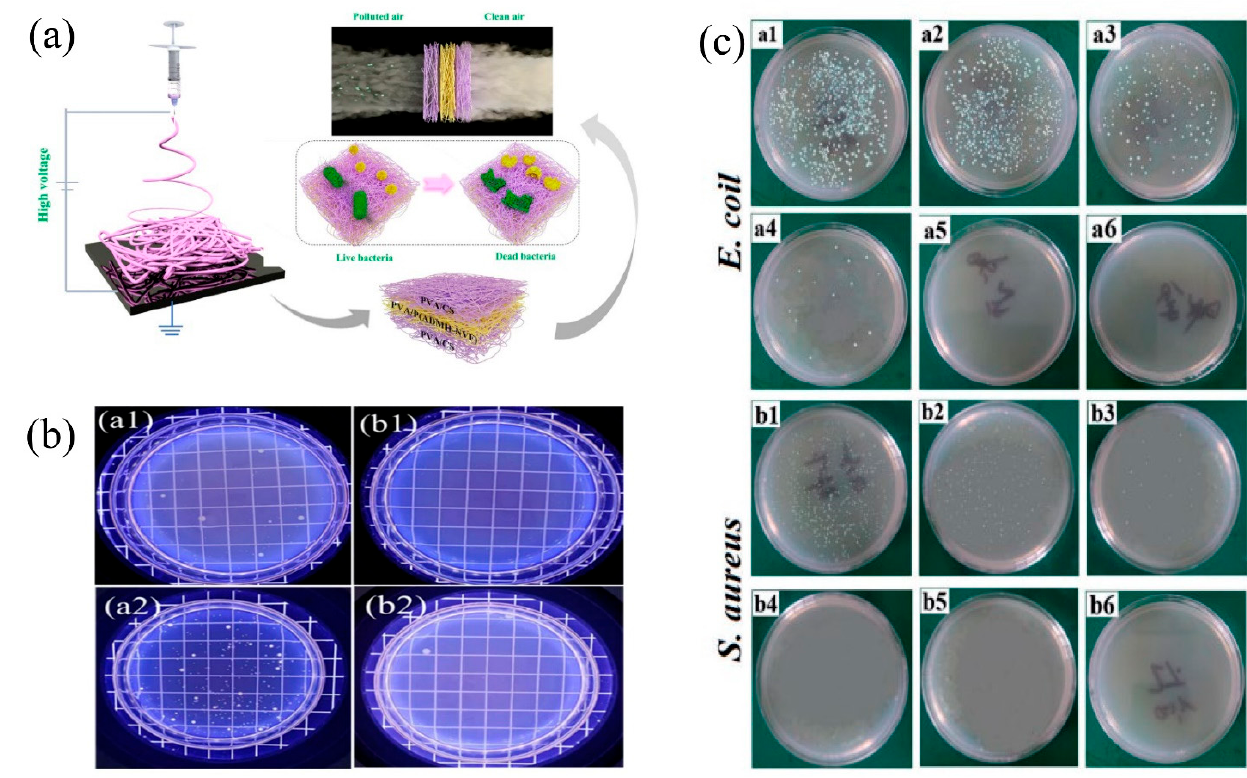
Figure 10. ( a ) Schematic illustration of fabrication of the multilayer membranes and application on the antibacterial air filtration. Reprinted with permission from ref. [55]. Copyright 2020 Elsevier B.V. ( b ) Representative images of the active colonies after 24 h incubation. Antibacterial efficacy of the samples ( a ) control, ( b ) PA6/CS-NPs against ( 1 ) E. coli and ( 2 ) S. aureus . Reprinted with permission from ref. [36]. Copyright 2020 Wiley Periodicals, Inc. ( c ) Photographs of surviving colonies of E. coli ( a ) and S. aureus ( b ) on nutrient agar dishes evaluated by the shake flask method for PAN/PU composite nanofibrous membranes with different added amount of AgTiO ( 1 ) 0.0% w / w , ( 2 ) 1.0% w / w , ( 3 ) 1.5% w / w , ( 4 ) 2.0% w / w , 2 ( 5 ) 2.5% w / w, and ( 6 ) 3.0% w / w . Reprinted with permission from ref. [72]. Copyright 2018 Yanpeng Wu et